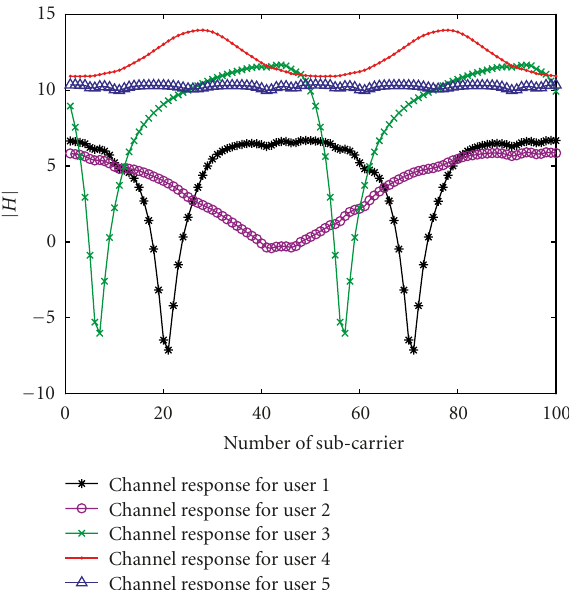
Figure 7: Channel responses in a typical urban environment experienced by 5 di ff erent